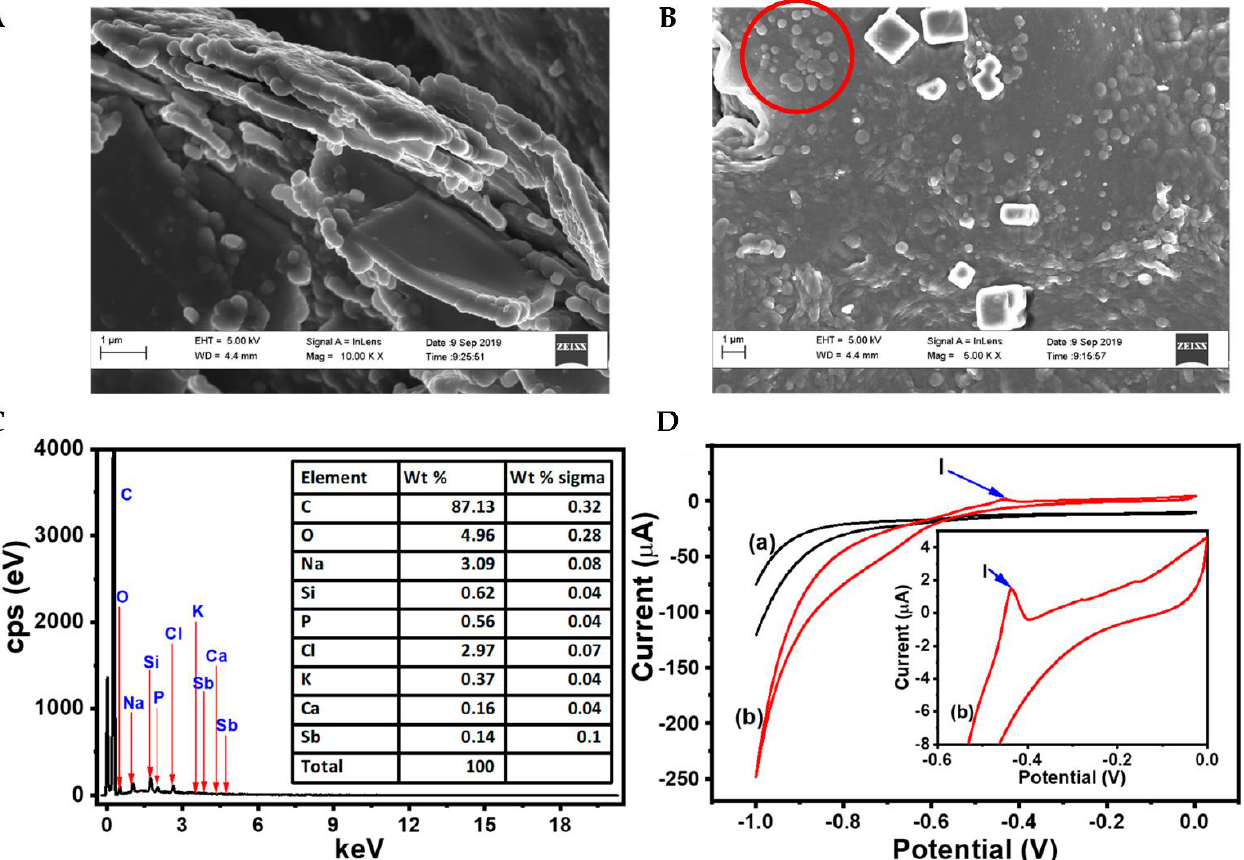
Figure 2. HRSEM of ERGO ( A ) and ERGO-SbNPs ( B ) on PGE surface, the accompanying EDX data in ( C ) showing elemental composition by weight%, and CV in ( D ) with comparison of ERGO-PGE (a) and ERGO-SbNPs-PGE (b) along with an inset of the magnified (b) in 0.5 mol·L −1 HCl solution at and ERGO-SbNPs-PGE (b) along with an inset of the magnified (b) in 0.5 mol · L − 1 HCl solution at a a scan rate of 50 mV·s −1 . scan rate of 50 mV · s − 1